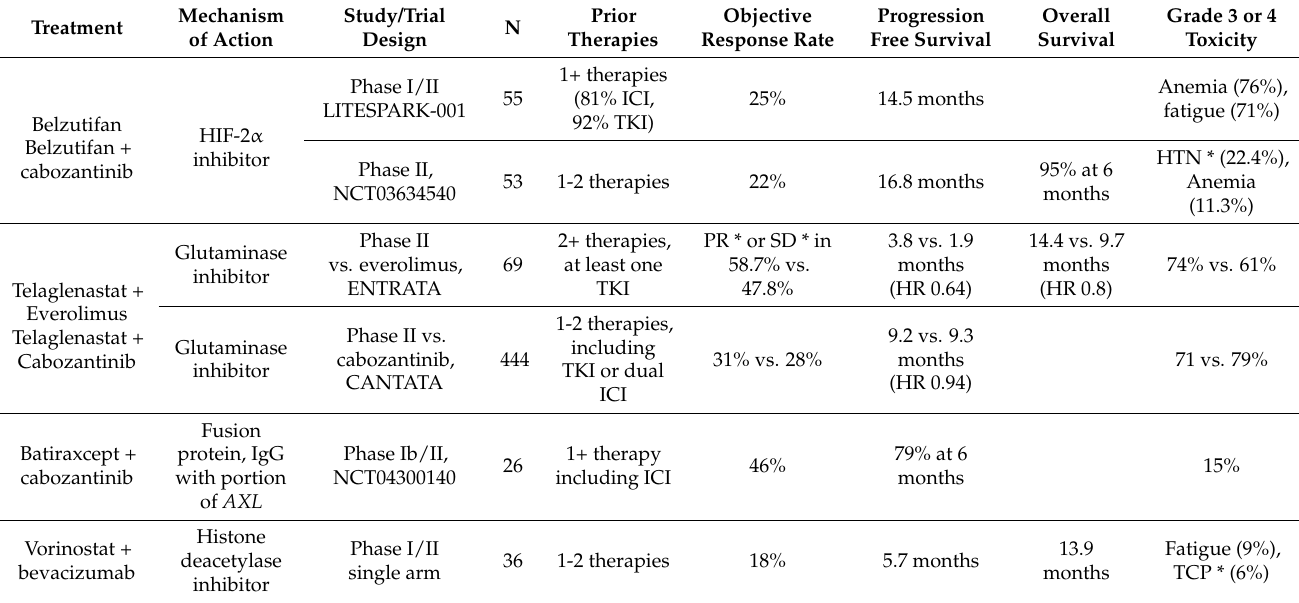
Table 3. Early phase trials in refractory